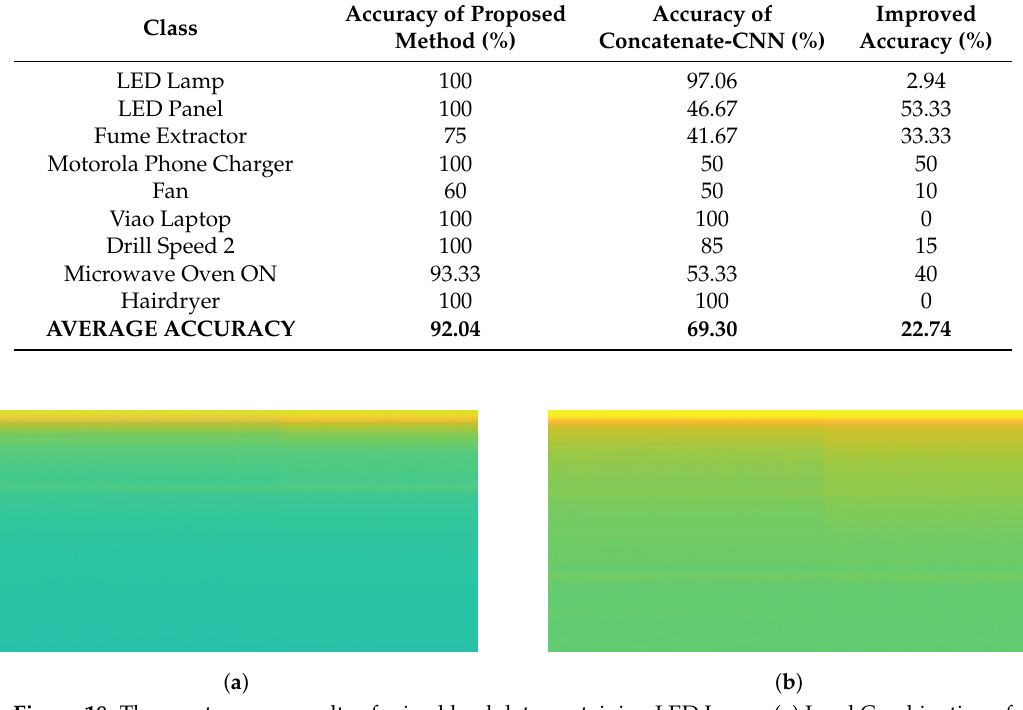
Figure 18. The spectrogram results of mixed load data containing LED Lamp: ( a ) Load Combination of Hair Dryer Super-2 and LED Lamp; ( b ) Load Combination of Hair Dryer Eleganza and LED